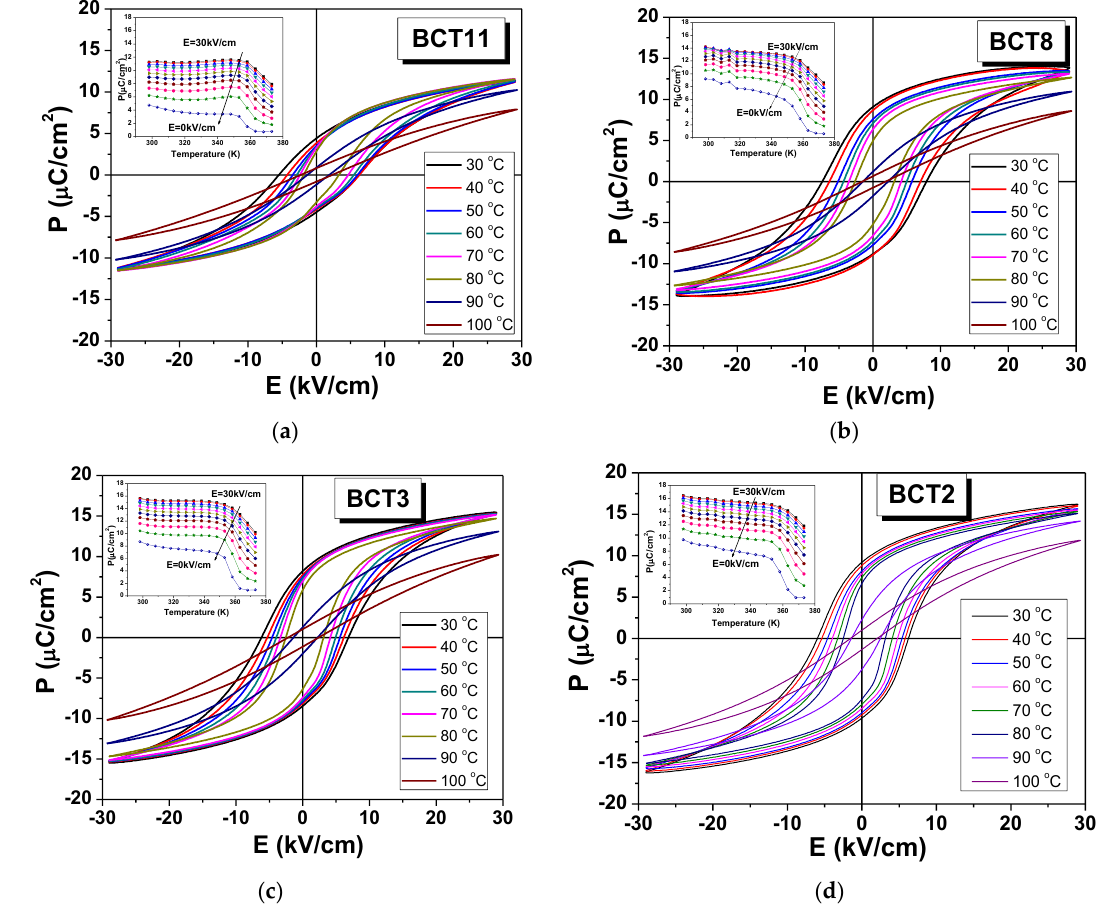
Figure 5. P(E) loops at a few selected temperatures for Ba 0.90 Ca 0.10 TiO 3 ceramics with different porosity levels: ( a ) 11%, ( b ) 8%, ( c ) 3%, and ( d ) 2% porosity. To calculate the adiabatic electrocaloric temperature change (ΔT) , the Maxwell rela- tion was used: